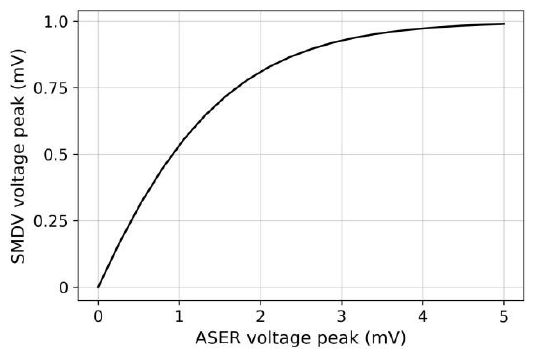
Figure 6. Logic function for mimicking klinokinesis behavior.